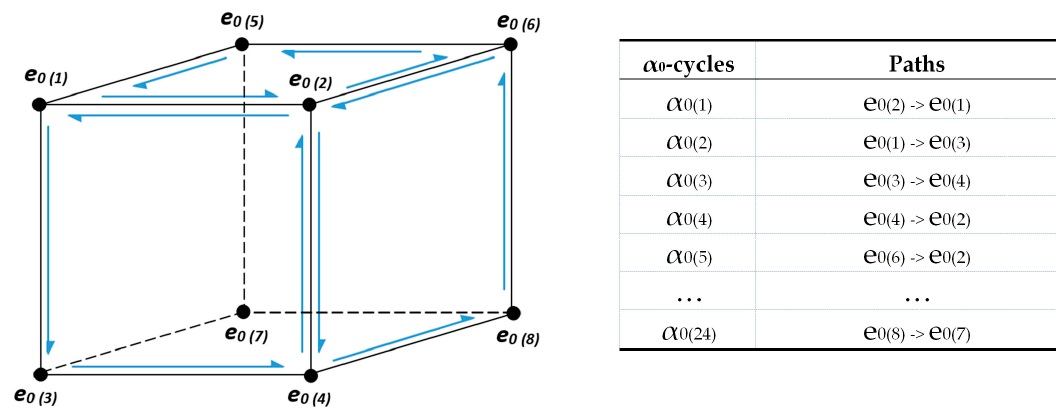
Figure 1. α 0 -cycles and their connectivity.